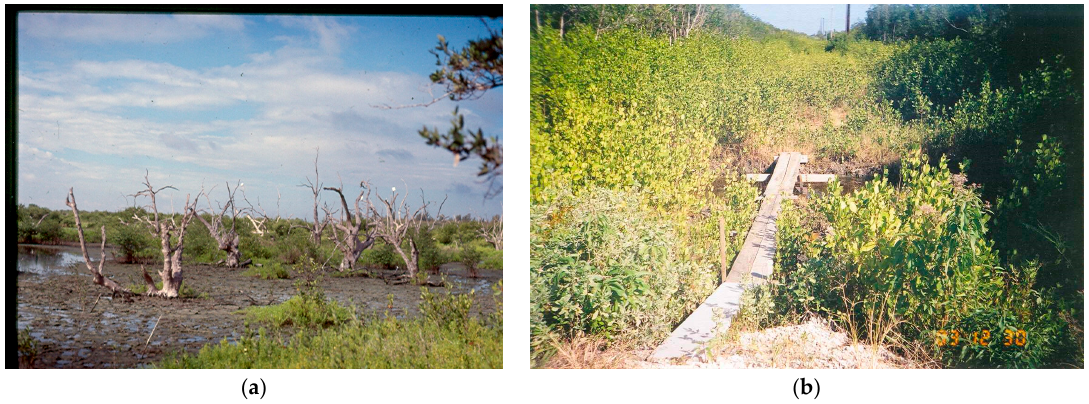
Figure 1. ( a ) A mosquito impoundment not connected to the adjacent Florida Indian River